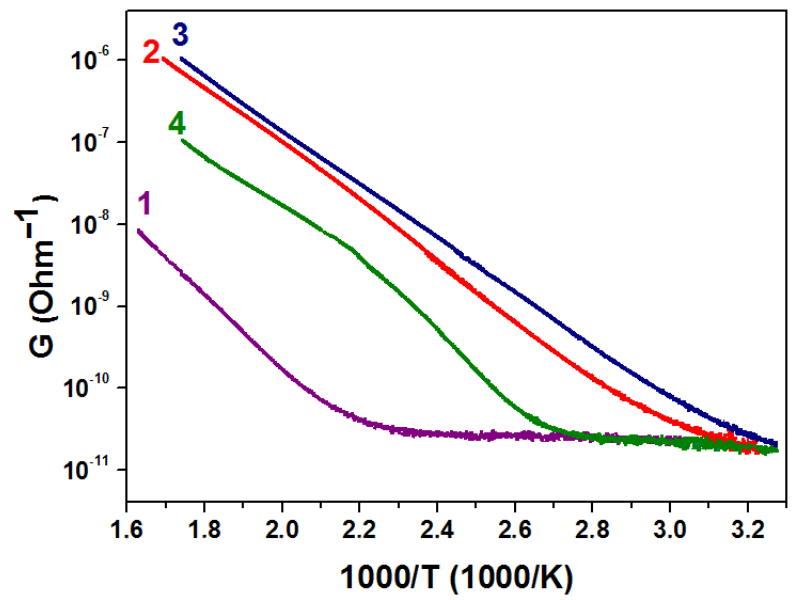
Figure 4. Conductivity dependences of the of ZnO-SnO 2 films with the Sn:Zn ratio equal to 0:100 (1), 0.5: 99.5 (2), 1: 99 (3), 5: 95 (4) on the reverse temperature. Table 1. Characteristics of ZnO-SnO 2 films obtained by solid-phase low-temperature pyrolysis technique.